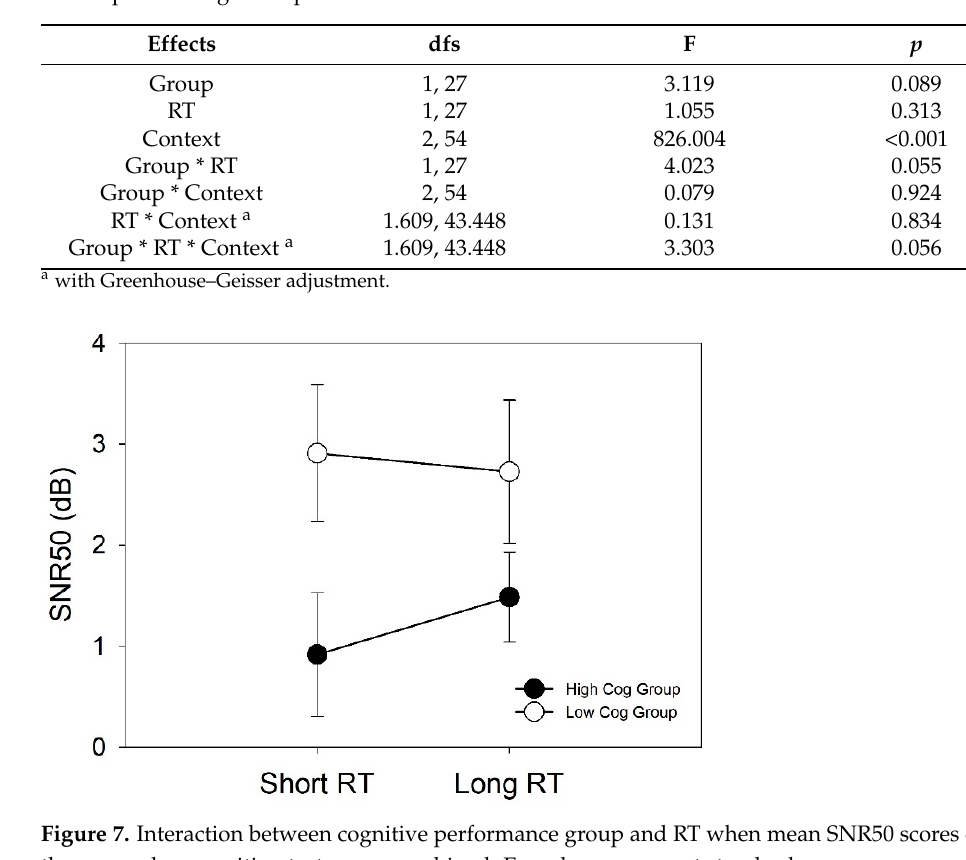
Table 2. Effects of release time (RT), cognitive abilities (group), and linguistic context (context) on aided speech recognition performance in the full model ANOVA.